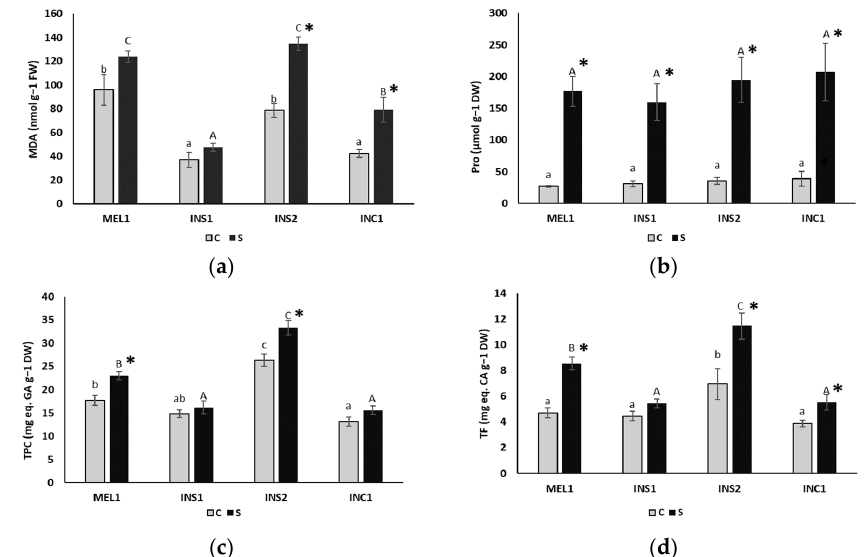
Figure 3. Variations in leaf MDA ( a ), proline ( b ), total phenolic compounds ( c ) and flavonoids ( d ) contents in plants of the indicated genotypes, after 18 days of control and water stress treatments. Accessions are defined in Table 1. Bars represent means ( n = 5) with standard errors. Different letters (lower case for control plants and upper case for water-stressed plants) indicate significant